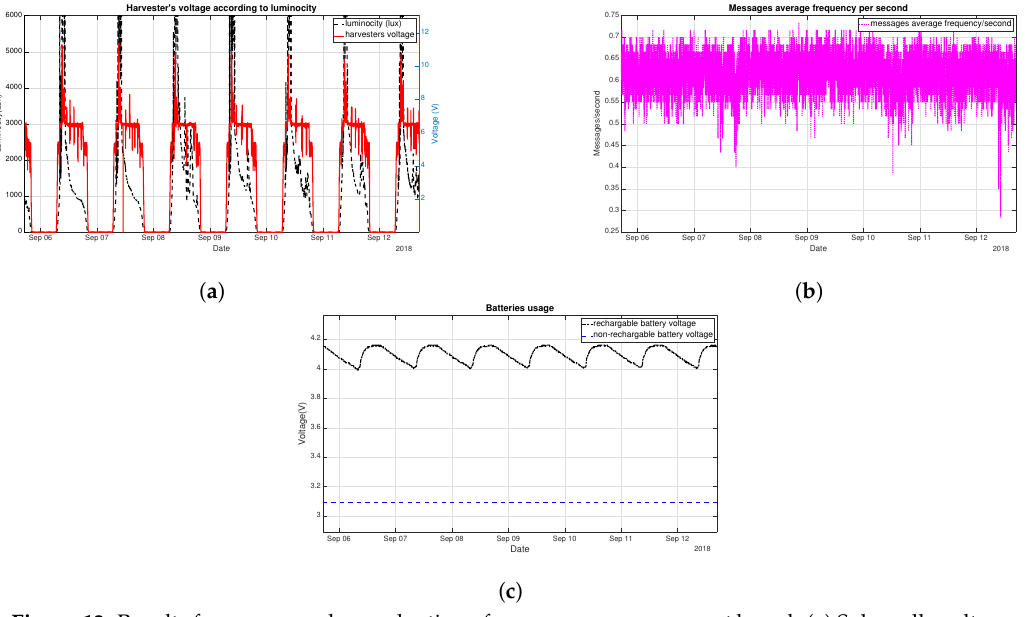
Figure 12. Results from a seven day evaluation of our energy management board. ( a ) Solar cells voltage according to the applied luminosity. ( b ) Average messages received per second from the mote. ( c ) Rechargeable and non-rechargeable battery